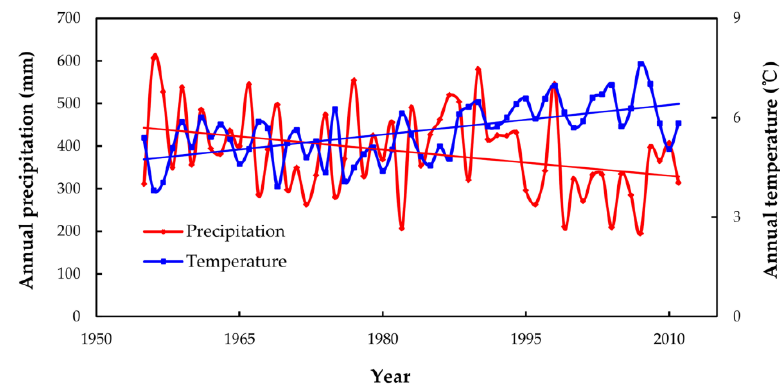
Figure 1. Trend of precipitation and temperature in the Momoge National Nature Reserve.